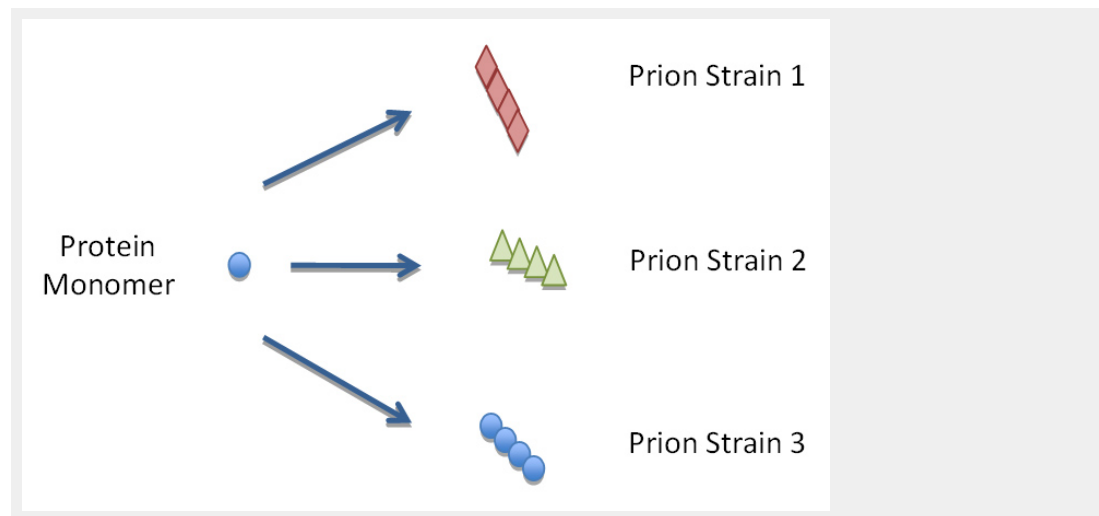
Figure 1B Yeast and mammalian proteins with prion domains have the ability to misfold into a multitude of different conformations that encipher different biochemical and biophysical